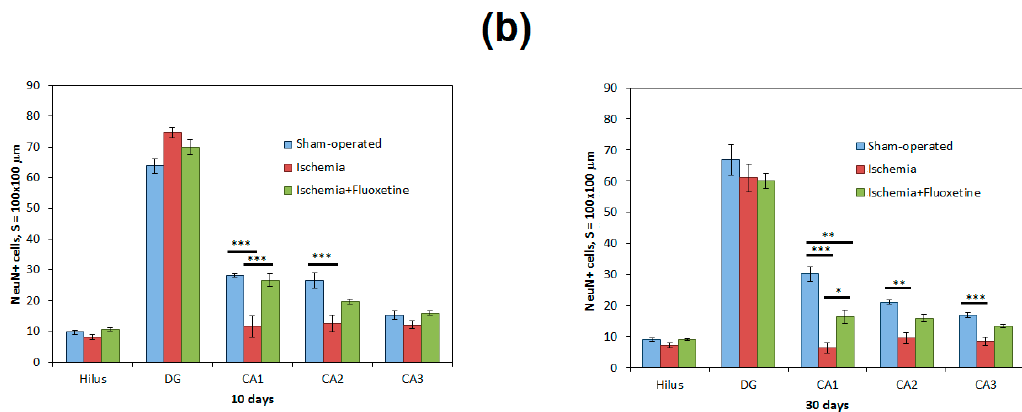
Figure 1. Fluoxetine effect on neuronal loss in the hippocampus after GCI. ( a ) Micrographs of the whole hippocampus of the sham-operated animals, positive controls, and fluoxetine-treated animals after GCI at days 11 and 31 after surgery, 10× magnification. Brain sections were stained with NeuN. ( b ) Comparison of total number of neurons in hippocampal regions per 100 × 100 µm 2 between the groups. Significant differences between the groups, according to ANOVA after Bonferroni’s correction for multiple comparisons: * p < 0.05, ** p < 0.01, *** p < 0.001.